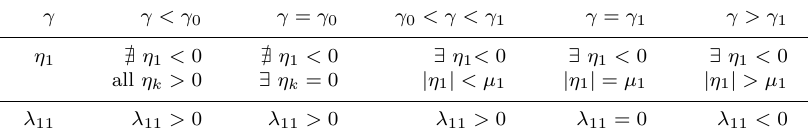
Table 1. The dynamics of the least eigenvalue λ 11 depending on γ